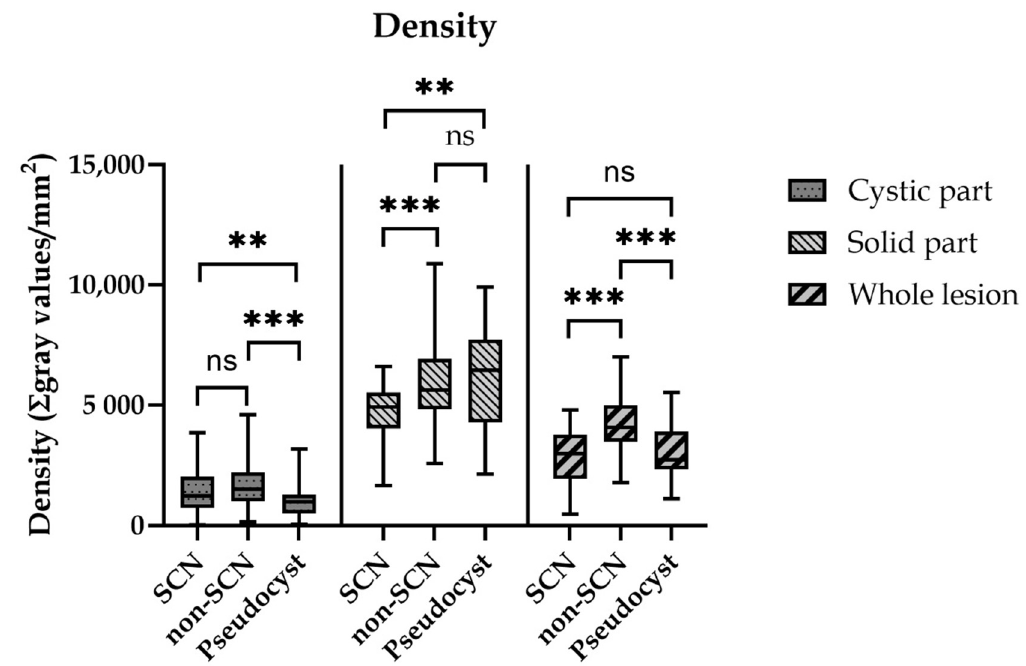
Figure 6. Density values of the different parts of cystic lesions. The density value meant the quotient of the sum of gray values in the selected area and the value of the selected area (ns = non-significant ** p < 0.005; *** p < 0.0005).